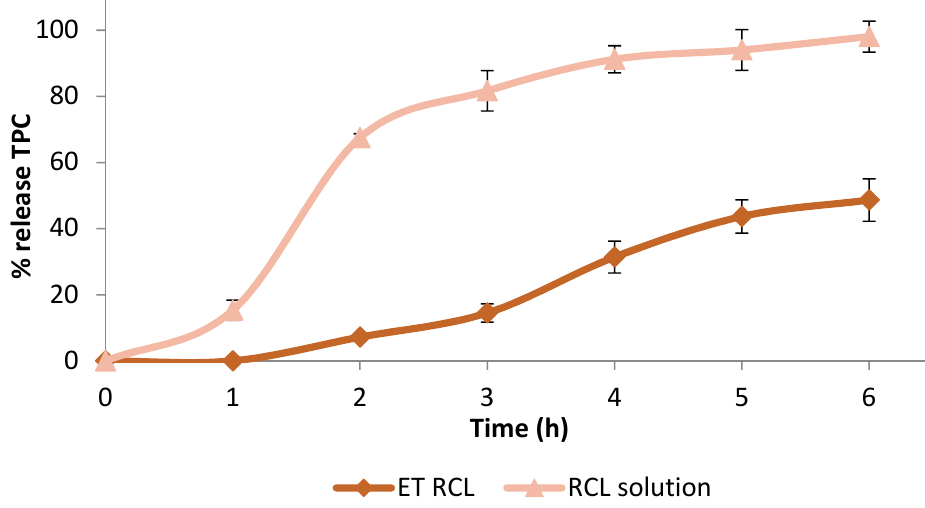
Figure 3. Size of unloaded (ET) and loaded ethosomes (ET RCL) during 20 weeks of storage at 4.0 ± 1.0 °C .